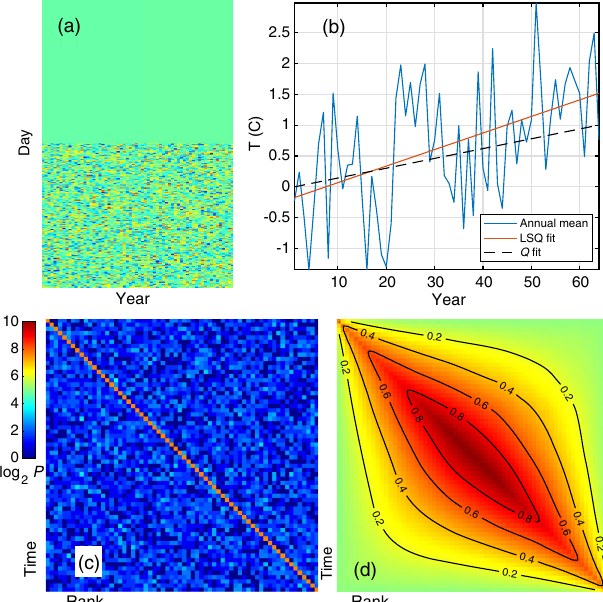
FIG. 3. An example of superior Q performance: Synthetic data for daily low temperature on Planet X (see text). (a) The data matrix. For the first half of the year, the temperatures are noise- free; only the trend of 1 °C over 64 years is present. During the second half of the year, large fluctuations are superimposed on the same trend. (b) A comparison of Q and LS fits for this imaginary station. The Q fit gives 1 . 0001 °C. The LS fit is thrown off by the noise, giving 1 . 69 °C with a confidence interval of [1.06, 2.31]. (c) The P (log scale) matrix, which shows the reason for the disparity. The exact data for the first half of the year result in a diagonal population of entries, while the second half of the year consists of randomly sprinkled entries. (d) Q is hardly perturbed by noise; each partition sees a positive excess domi- nated by the diagonal population of entries, while the second half of the year consists of nearly randomly distributed entries.